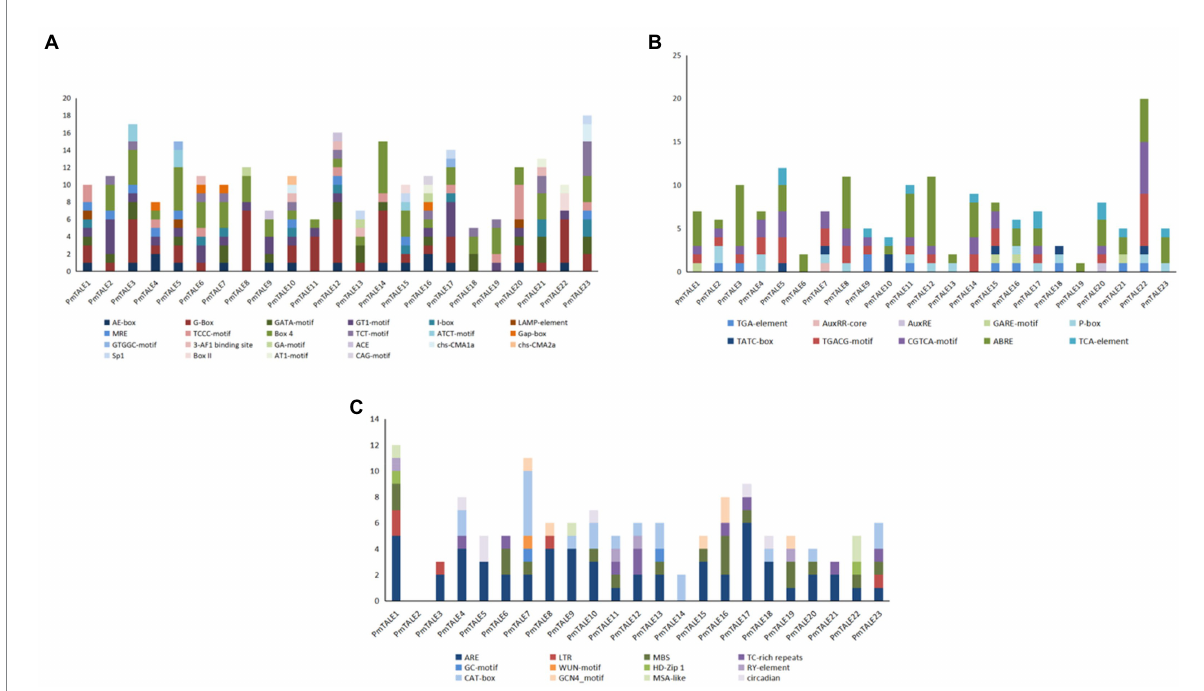
FIGURE 10 Cis element analysis of promoter of Prunus mume TALE gene family members. (A) shows the types and numbers of light-responsive elements contained in the TALE gene promoter; (B) shows the types and numbers of hormone response elements contained in the TALE gene promoter; and (C) shows the types and numbers of other elements contained in the TALE gene promoter. The ordinate represents the number of